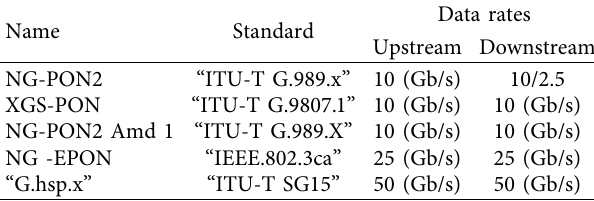
Table 3: Technology standards